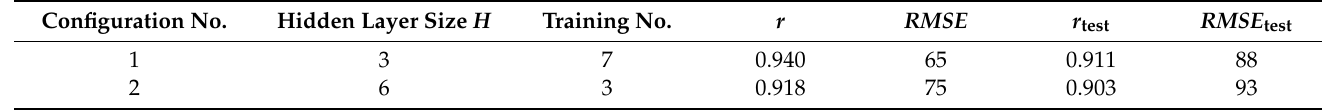
Table 5. Artificial neural network performance on learning